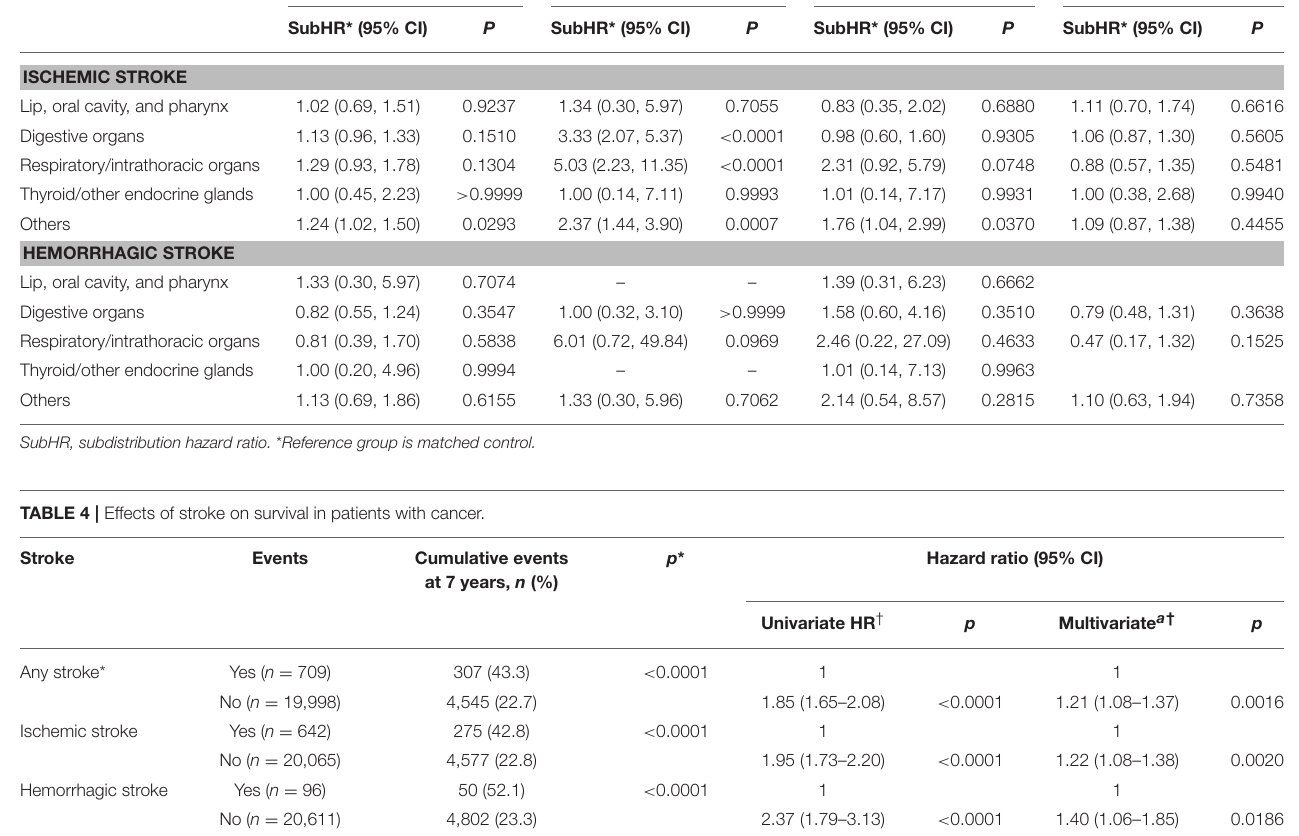
TABLE 3 | Risk of stroke based on time since first cancer diagnosis. Organ